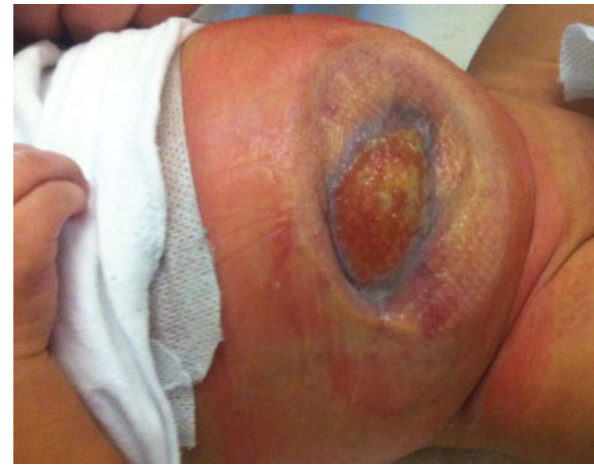
Fig. 4 Gastroschisis on day of life 78, showing wound